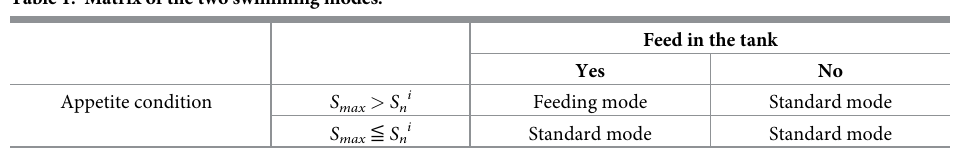
Table 1. Matrix of the two swimming modes.